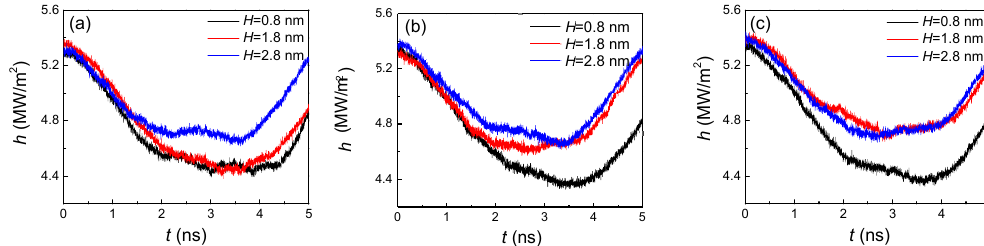
Figure 6. The heat flux at the region near the cold wall by 1 nm with three groove heights and widths of ( a ) 1.8, ( b ) 2.4, and ( c ) 3.2 nm on hydrophilic surfaces.